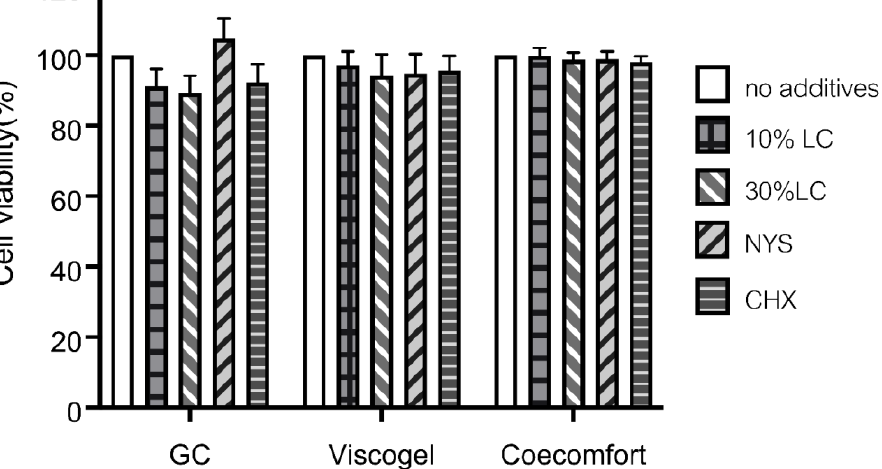
Figure 3. Cell viability (%) of GC soft liner, Viscogel and Coe comfort incorporated with various additives compared to soft lining materials without additive. No statistical difference was found among the same soft lining materials ( p > 0.05). Note: 5% v / v of 2% chlorhexidine gluconate (CHX) and NYS 30% v / v nystatin oral suspension (NYS).